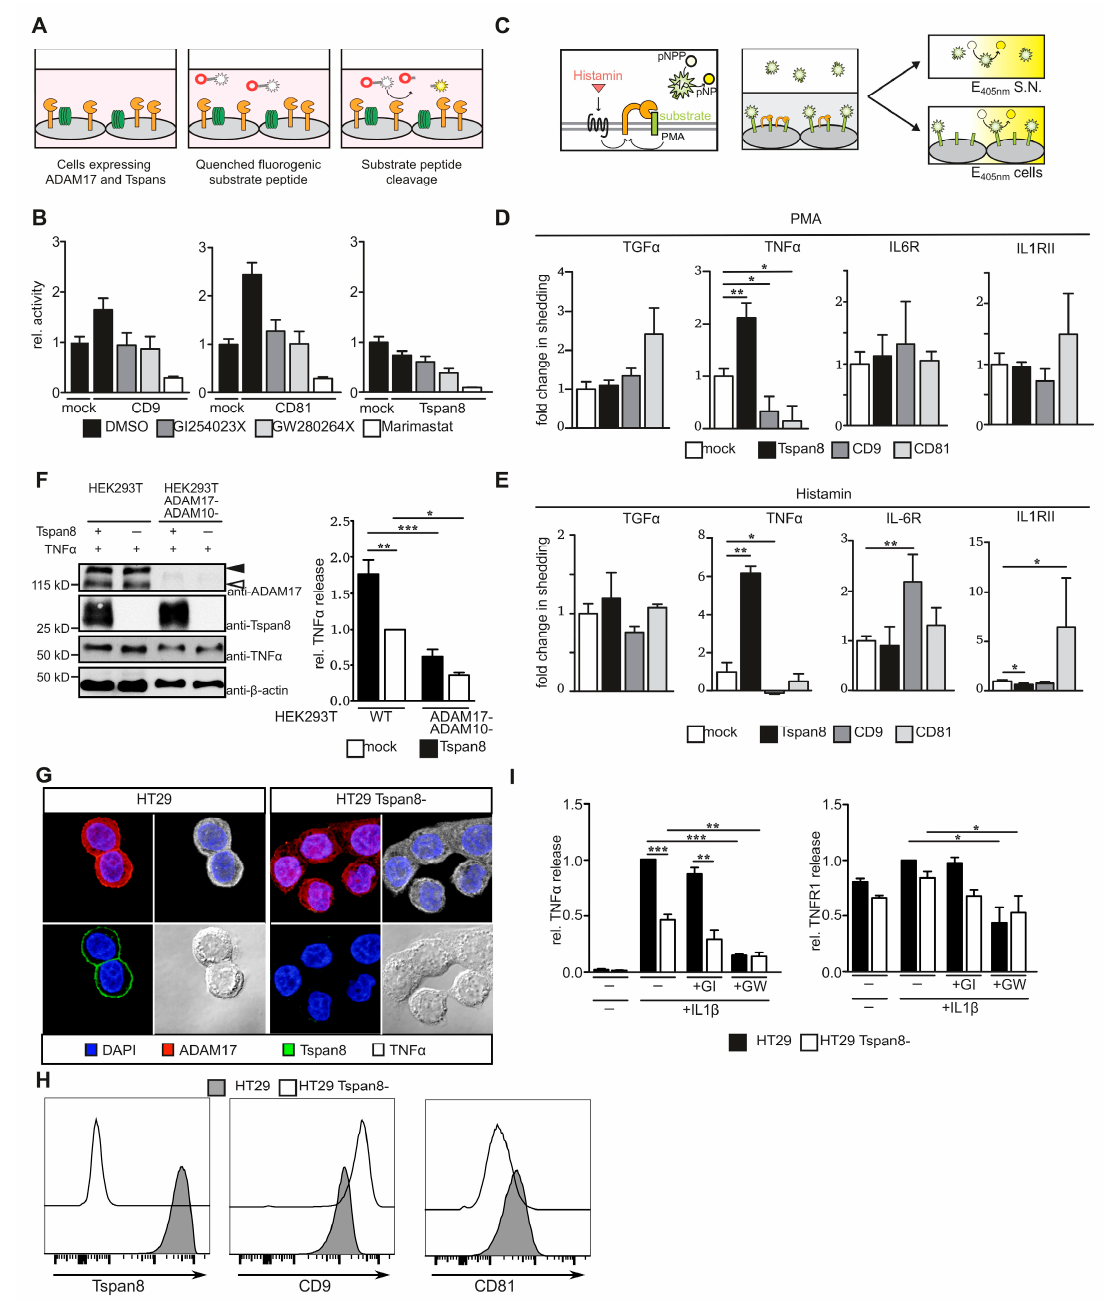
Figure 3. ADAM17 substrate shedding is selectively regulated by Tspan8 subfamily members. ( A ) Schematic of cell surface ADAM17 activity assay using a quenched fluorogenic peptide. ( B ) Cell surface enzymatic activity of ADAM17 is unaltered in the presence of CD9, CD81 or Tspan8, while cell surface enzymatic activity of ADAM10 is enhanced in the presence of CD9 or CD81. ( C ) Schematic of AP-shedding assay in HEK293T cells. Adapted from [40] ( D ) PMA-stimulated TNF α - shedding is enhanced in HEK293T cells overexpressing Tspan8 but impaired in HEK293T cells overexpressing CD9 or CD81. ( E ) ADAM17 substrate shedding is differentially regulated by Tspans in HEK293T cells overexpressing CD9, CD81 or Tspan8. Stable HEK293T cells were transfected with a plasmid encoding histamine 1 receptor and cells were stimulated with 10 µM histamine. ( F ) Tspan8-mediated increase in TNF α -shedding is dependent on ADAM17. Left panel: immunoblot of